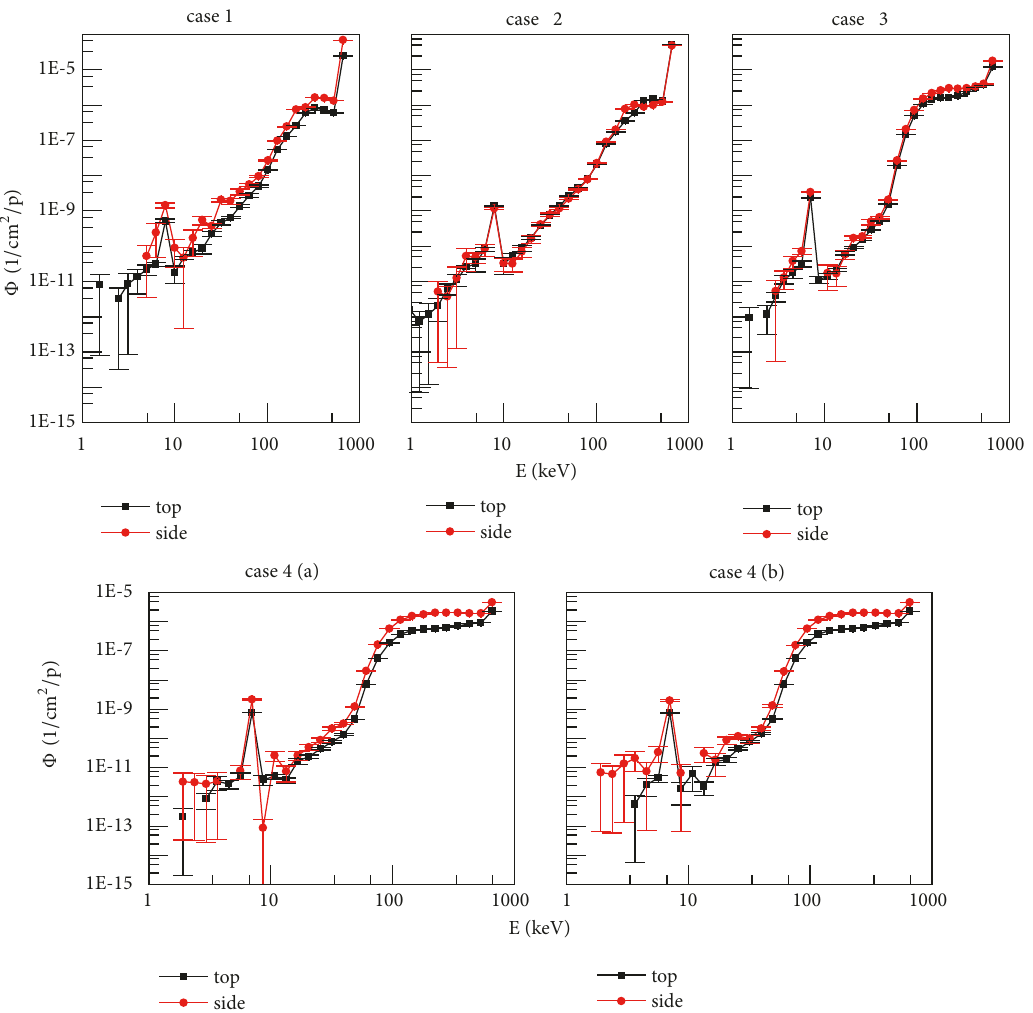
Figure 7: FLUKA-calculated flux results for the four cases. Case 4 (a): direct calculation. Case 4 (b): optimized setting and VRT